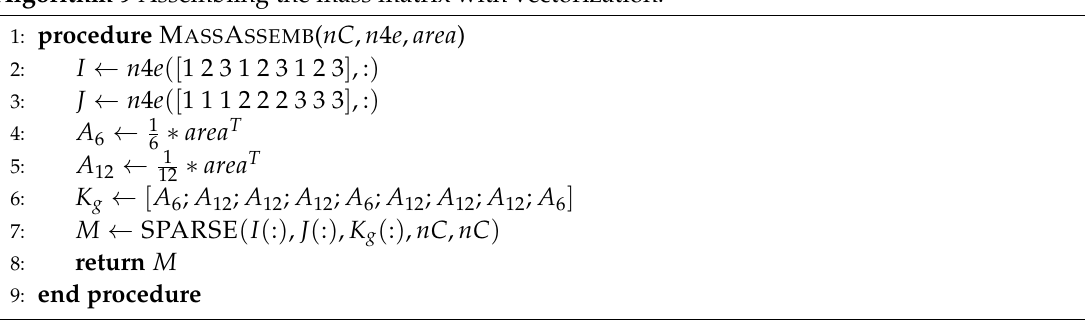
Algorithm 9 Assembling the mass matrix with